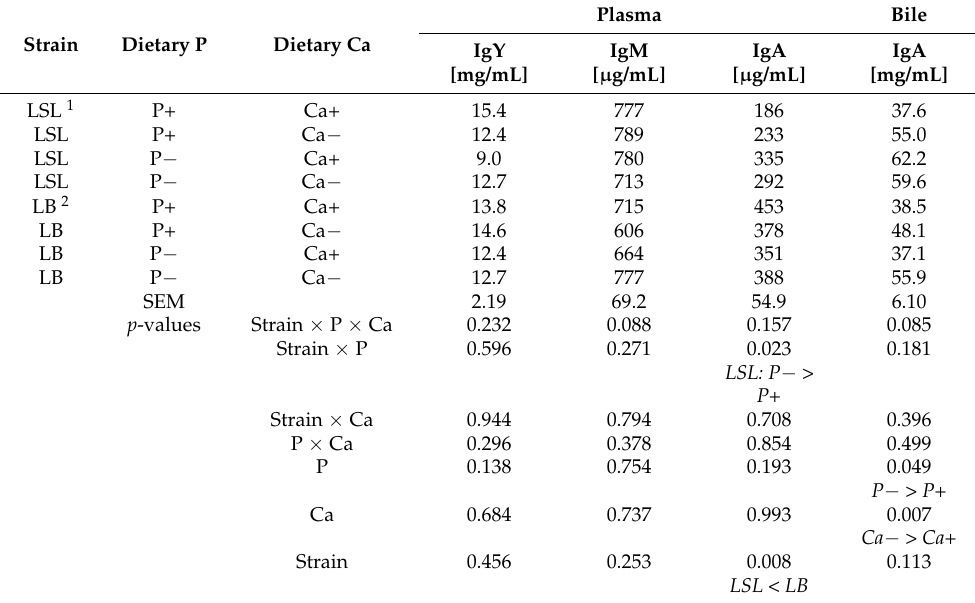
Table 4. Effect of strain, dietary P, and dietary Ca on antibody concentrations in plasma and